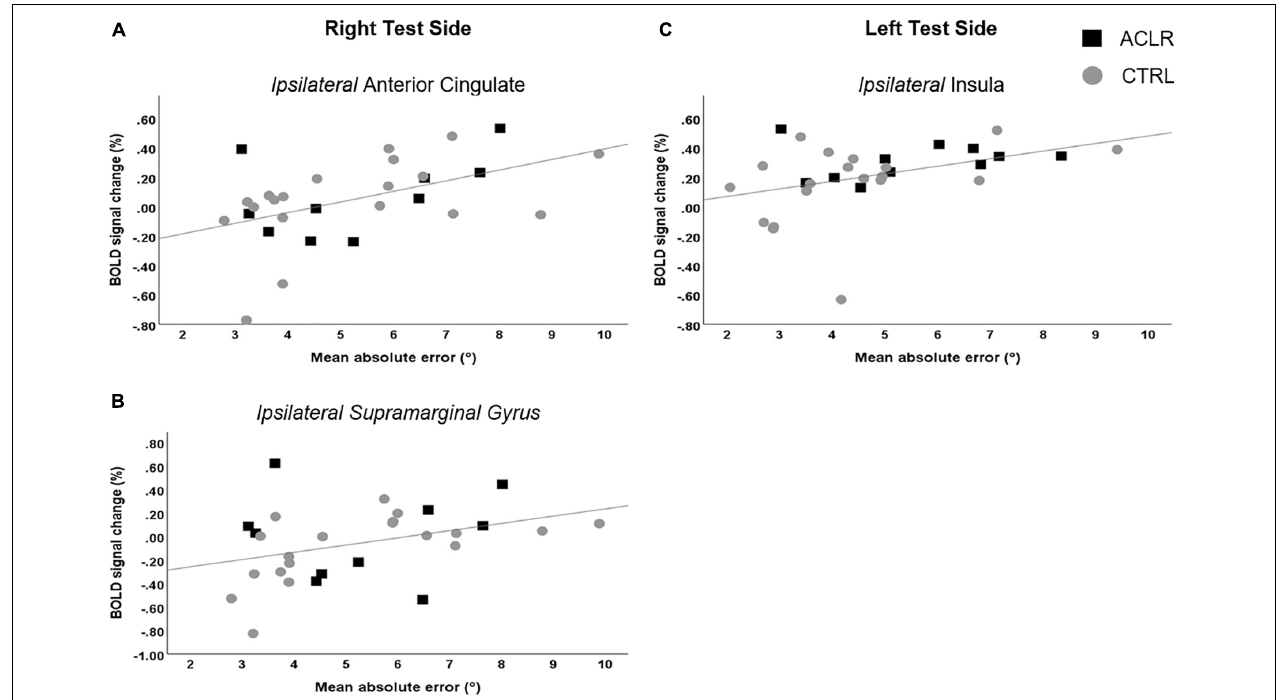
FIGURE 5 | Scatter plots illustrating the significant correlations between mean knee joint position sense absolute errors and simultaneous percentage change in BOLD response for the right test side (A,B) and the left test side (C) .